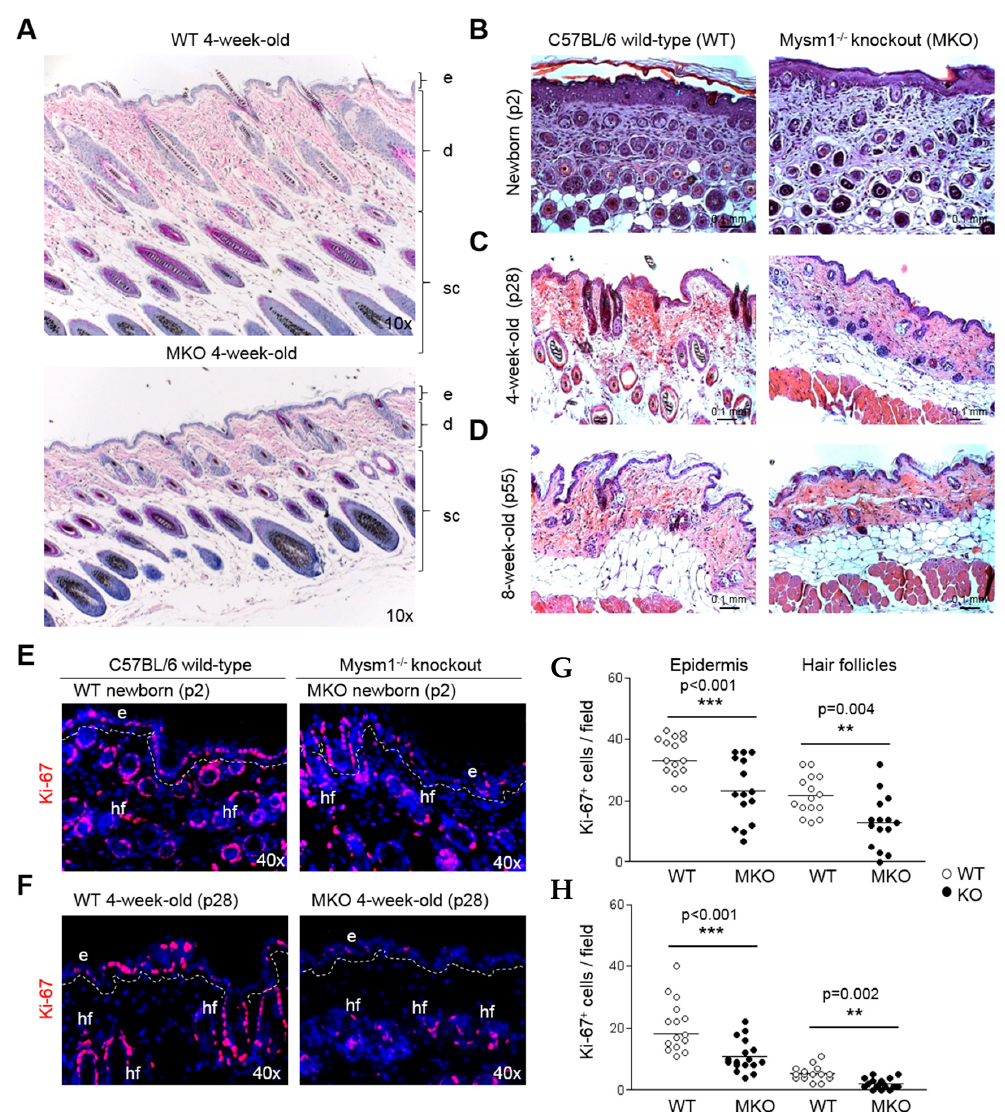
Figure 2. Skin of Mysm1-deficient mice is atrophic. ( A – D ) Hematoxylin & Eosin staining of paraffin-embedded skin samples derived from three different age groups of Mysm1-deficient mice and their wild-type littermates, as indicated (e: epidermis, d: dermis, sc: subcutis); ( E – H ) IF analysis of proliferation marker Ki-67 in ( E ) newborn and ( F ) 4-week-old Mysm1 − / − and wild-type skin, and corresponding statistical summaries (Ki-67 in red, DAPI-stained nuclei in blue, n > 4, representative images shown, original magnification 40×, each dot in the graphical summary represents the count of Ki-67 + cells in one high power field) in skin of ( G ) newborn and ( H ) 4-week-old mice.